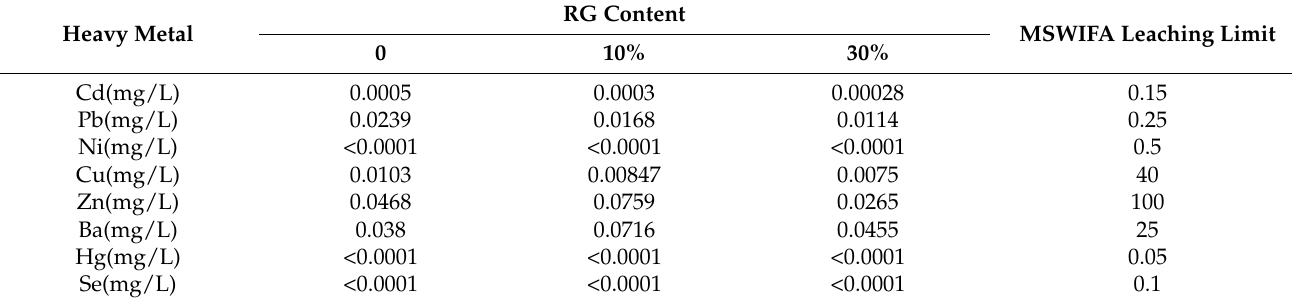
Table 6. The leaching amount of heavy metals from MSWI fly ash.